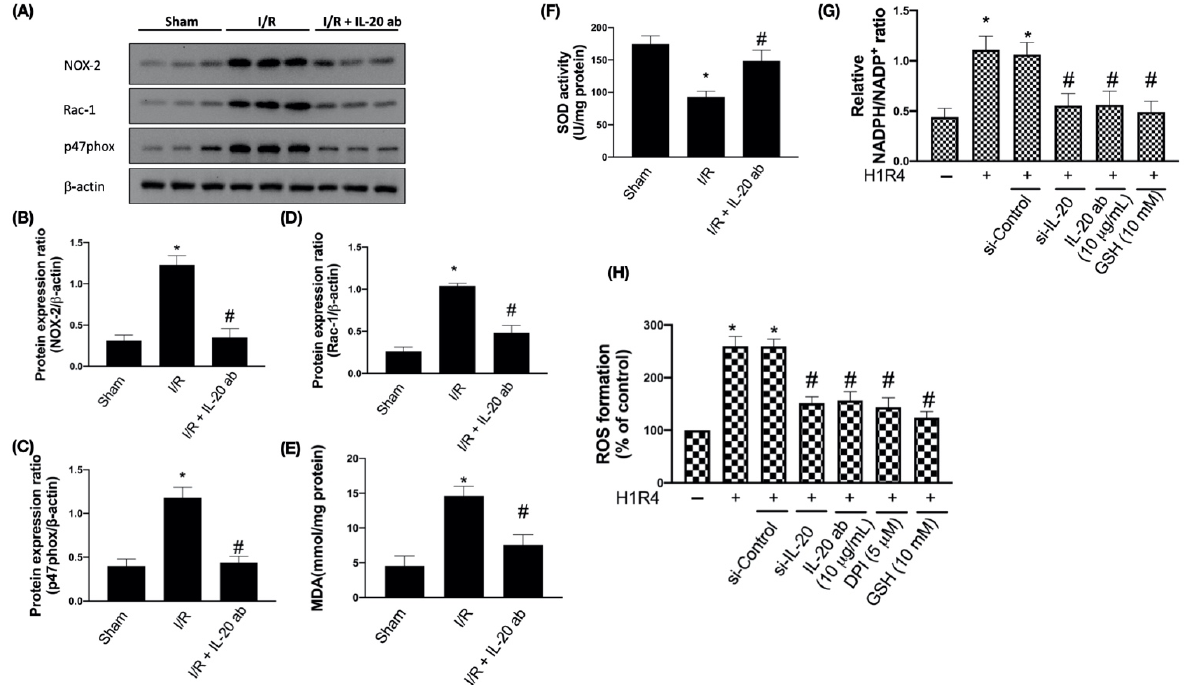
Figure 1. Interleukin (IL)-20 antibody reduces ischemia/reperfusion (I/R)-induced oxidative stress through nicotinamide adenine dinucleotide phosphate (NADPH) oxidase inhibition. Sprague Dawley rats receiving sham operation or ischemia/reperfusion (I/R) treatment were studied. In the IL-20 antibody treatment group, animals were injected with 5 mg/kg IL-20 antibody at the phase of reperfusion. The left ventricular tissues were collected for Western blotting assay. Representatives of Western blot ( A ), and the densitometric analysis of NADPH oxidase-2 (NOX-2) ( B ), p47phox ( C ), and Rac-1 ( D ) were shown. Plasma malondialdehyde (MDA) concentration ( E ) and superoxide dismutase (SOD) activity ( F ) were checked. The data were presented as the mean ± standard deviation (SD) of six animals in each group. ( G ) NADPH oxidase activity in H9C2 cells after hypoxia/reoxygenation (H/R) was presented by NAPDH/NADP + ratio. H9C2 cells that had been first exposed to hypoxia chamber with oxygen-glucose deprivation (OGD) for 1 h were moved into the normoxia chamber with high glucose medium for further 4 h, a condition abbreviated as H1R4. In some cases, cells were transfected with si-Control or si-IL-20 for 48 h before OGD. In the IL-20 antibody treatment group, 10 μ g/mL IL-20 antibody was added to medium during H/R. Glutathione (GSH), an antioxidant, was used for mitigating oxidative stress. ( H ) Reactive oxygen species (ROS) concentration was investigated by the cell-permeant 2',7'-dichlorodihydrofluorescein diacetate. Diphenyleneiodonium chloride (DPI), an inhibitor of NADPH oxidase, was used to inhibit H/R-induced NADPH oxidase activation. Data were presented as the mean ± SD of three different experiments. (* indicating p < 0.05 compared to the sham group or normoxia control cells; # indicating p < 0.05 compared to the I/R group or H/R cells). Sham: thoracotomy without ischemia/reperfusion; I/R: thoracotomy with ischemia/reperfusion; I/R + IL-20 ab: thora-cotomy with ischemia/reperfusion plus IL-20 antibody injection. “ − ” indicated cells were exposed to normoxia cham-ber; “+” indicated cells were exposed to hypoxia chamber for 1 h followed by 4 h